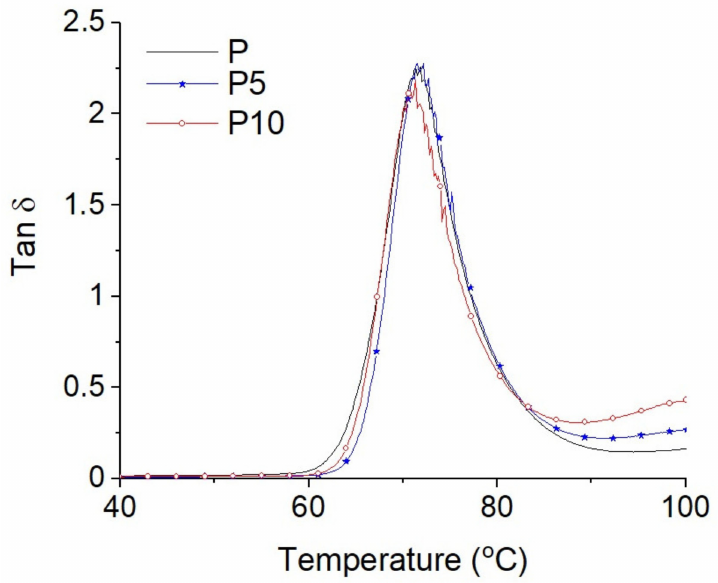
Figure 5. Damping coefficients (tan δ ) of samples P, P5, and P10.